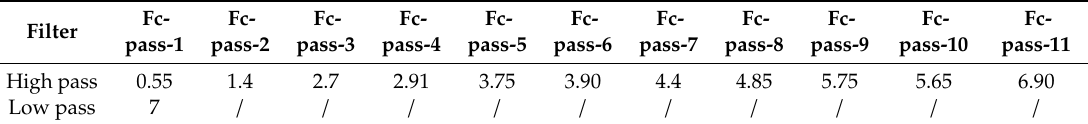
Table 2. Hyper high-pass filtering setup (in